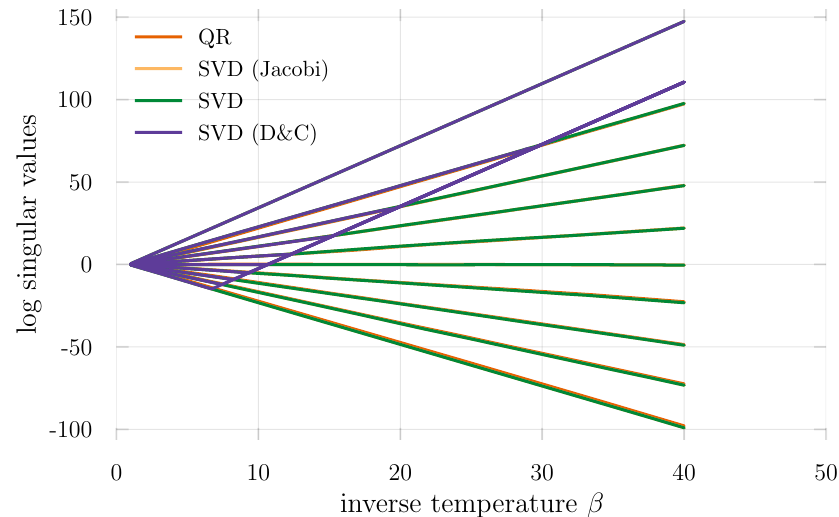
Figure (8) Comparison of matrix decompositions in the calculation of the time ··· B B slice matrix chain product B near a metallic antiferromagnetic quan- M M − 1 1 tum critical point (the spin-fermion model considered in Ref. [ 1 ] ). Different lines represent a selection 12 of logarithmic singular values as observed in the stabilized computations. The divide-and-conquer SVD (purple) shows large deviations at low temperatures β (cid:166) 8 ( ∆ τ = 0.1) while the other matrix decompositions are in ap- proximate agreement (on top of each